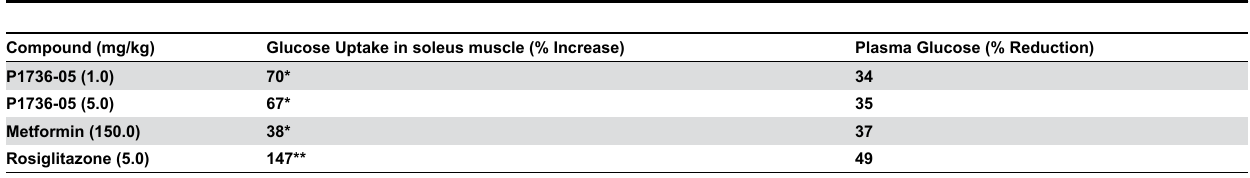
Table 1. Effect of P1736 on Plasma Glucose and Glucose Uptake in Isolated Soleus Muscles of ob/ob mice.